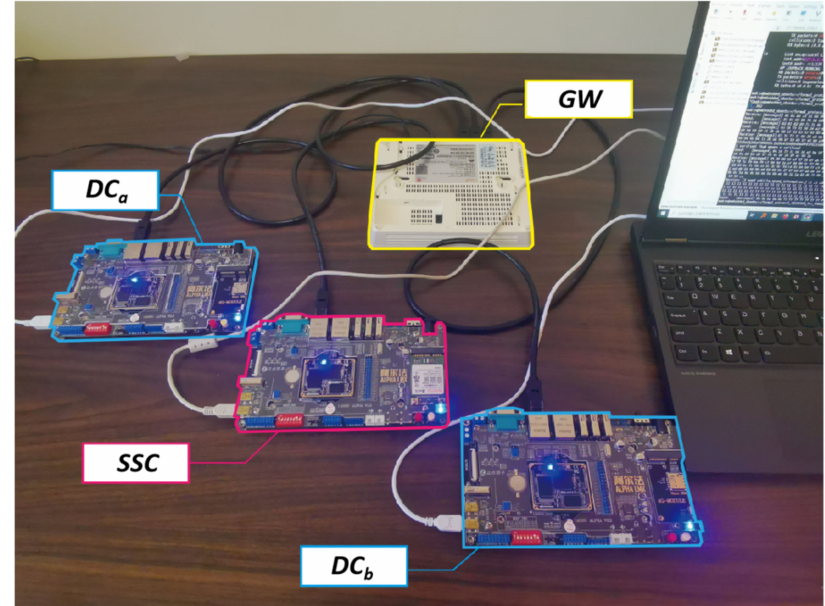
Figure 9. Experimental